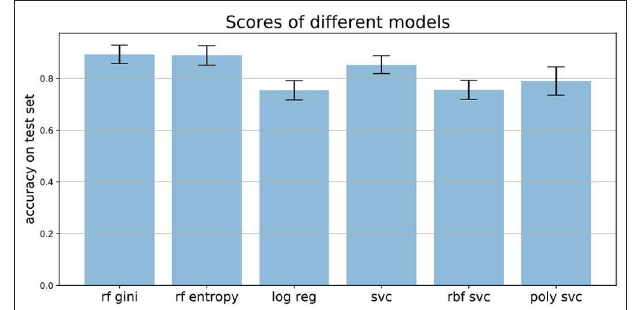
FIGURE 7 | Mean accuracies on test set of different models applied to the Speech Data Set (see section 3.4 for more information on data set). Error bars come from 100 independently trained models each. rf gini, Random forest with Gini impurity; rf entropy, random forest with entropy impurity; log reg, logistic regression; svc, support vector machine with linear kernel; rbf svc, support vector machine with Gaussian kernel; poly svc, support vector machine with polynomial